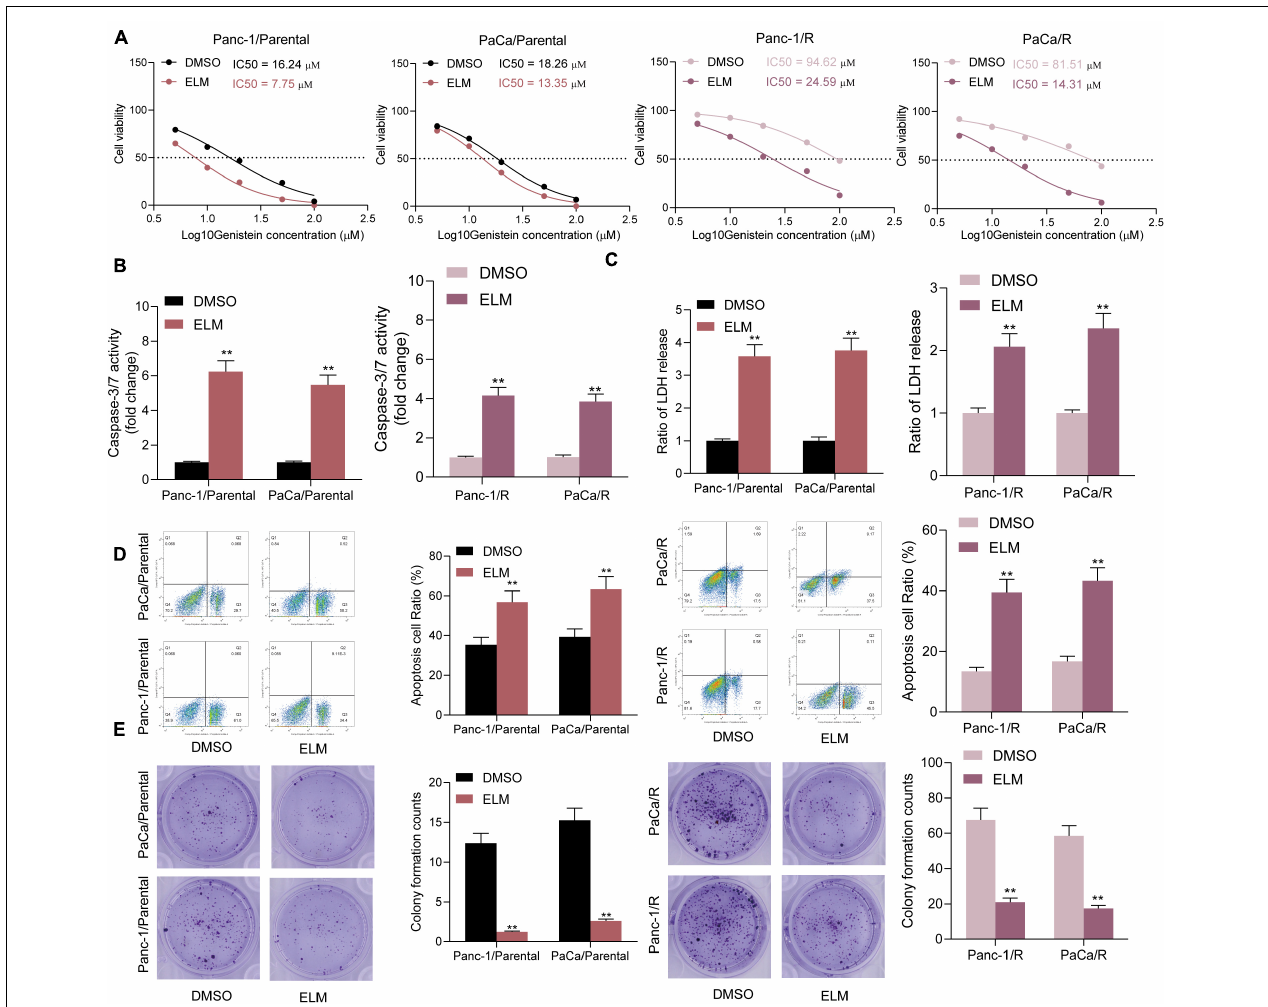
FIGURE 3 | Administration of ELM increases sensitivity of PC cells to genistein. (A) IC50 of genistein in parental and genistein-resistant cells determined by a CTG kit. (B) Activity of Caspase-3/7 in cells examined by a caspase-3 kit. (C) Lactate dehydrogenase (LDH) release in cells detected using an LDH release kit. (D) Apoptosis rate in PC cells detected using flow cytometry. (E) Viability of cells evaluated using the colony formation assay. Data were collected from three independent experiments and presented as mean ± SD. ** p <